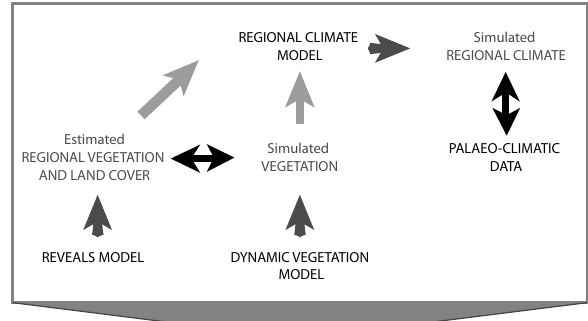
Model-data comparison scheme for the LANDCLIM project. The simple arrows represent model inputs or outputs. The double arrows represent the model-data comparison steps. RE- VEALS model (Sugita 2007a); dynamic vegetation model= LPJ- GUESS (Smith et al., 2001); regional climate model=RCA3 (Kjell- str¨om et al., 2005). For details, see